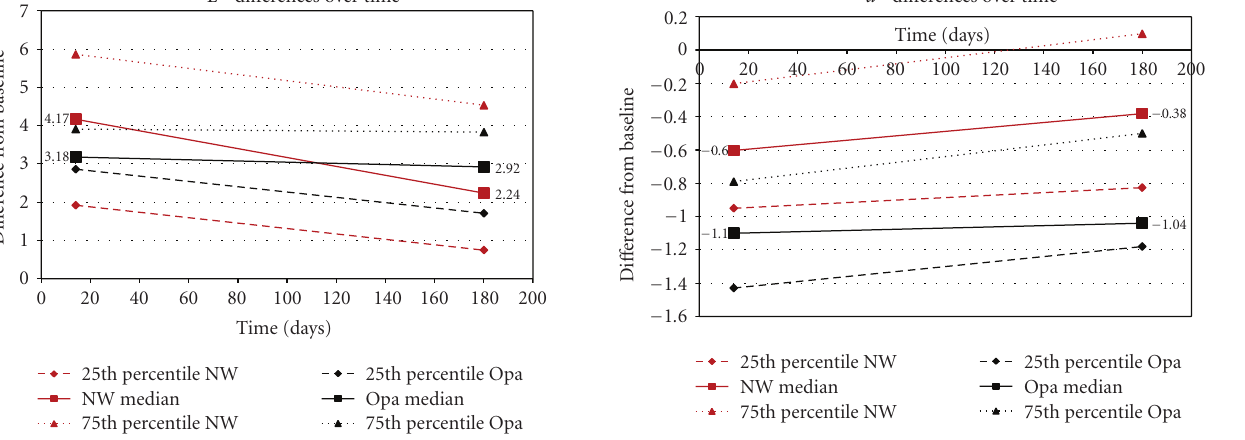
Figure 1: Opalescence (Opa) and Nite White (NW). The 25th percentile, median, and 75th percentile di ff erences in the L ∗ values between the baseline (before treatment) and after treatment (14 days) and between baseline and after 6 months.